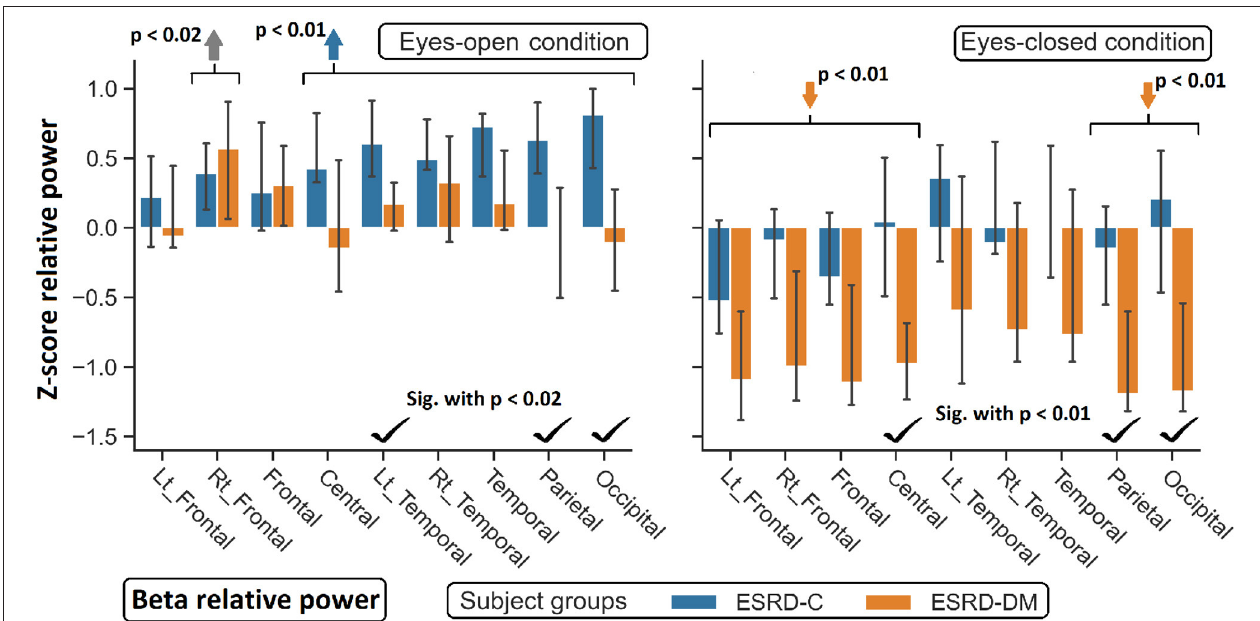
FIGURE 6 | Z-scores of beta relative power were found significant difference between ESRD-C and ESRD-DM as signified by check mark. Comparing to healthy control, ESRD-DM has lower beta in most regions (orange arrows), while ESRD-C has higer beta in most regions (blue arrows). P -values were calculated by Mann–Whitney U -test. The whisker indicates 95 percent confident intervals with median as an estimator. Gray arrow refer to significant difference from healthy control in both group.